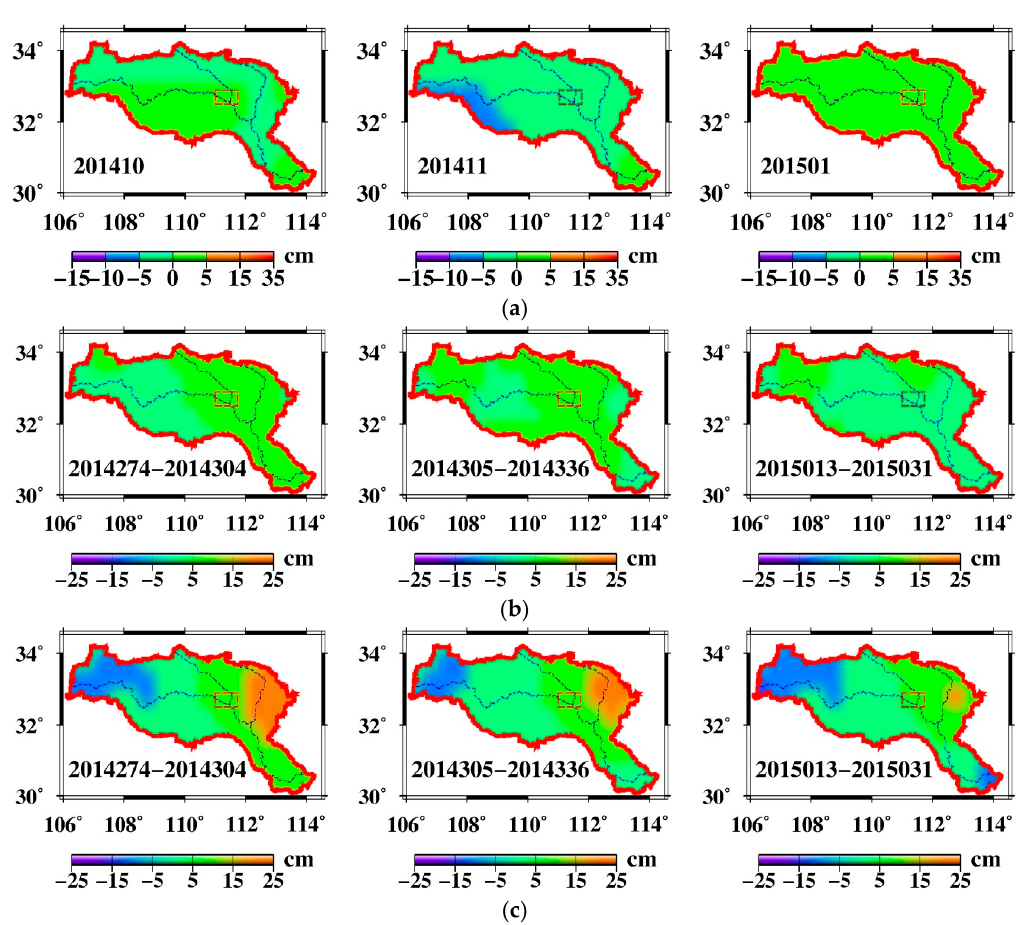
Figure 8. ( a ) Trends of the changes in precipitation from the TRMM, ( b ) total surface water storage from GRACE-GLDAS, and ( c ) human-induced surface water storage from GRACE-CLM4.0 during the period of 2003–2015.